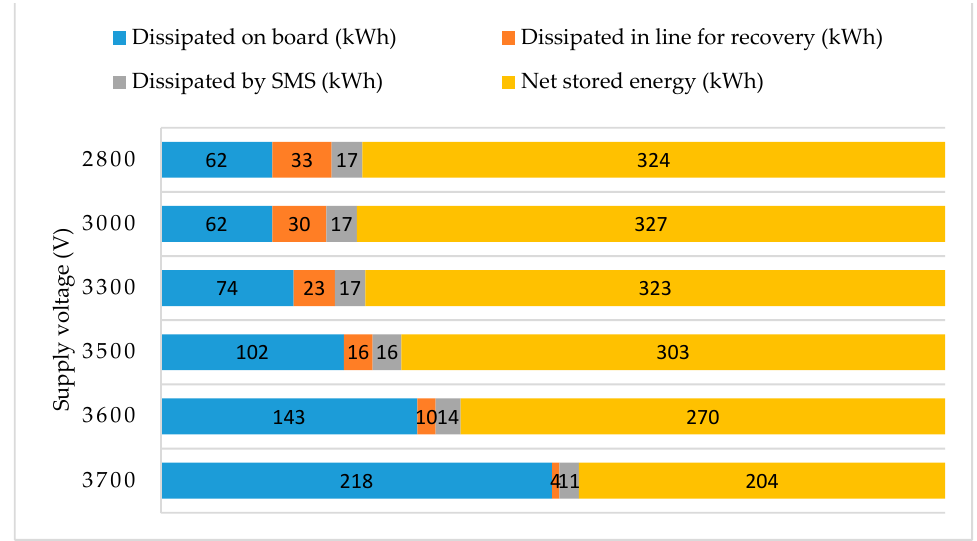
Figure 9. Energy analysis with two stationary ESSs in Cesena and Imola on varying the supply line voltage.